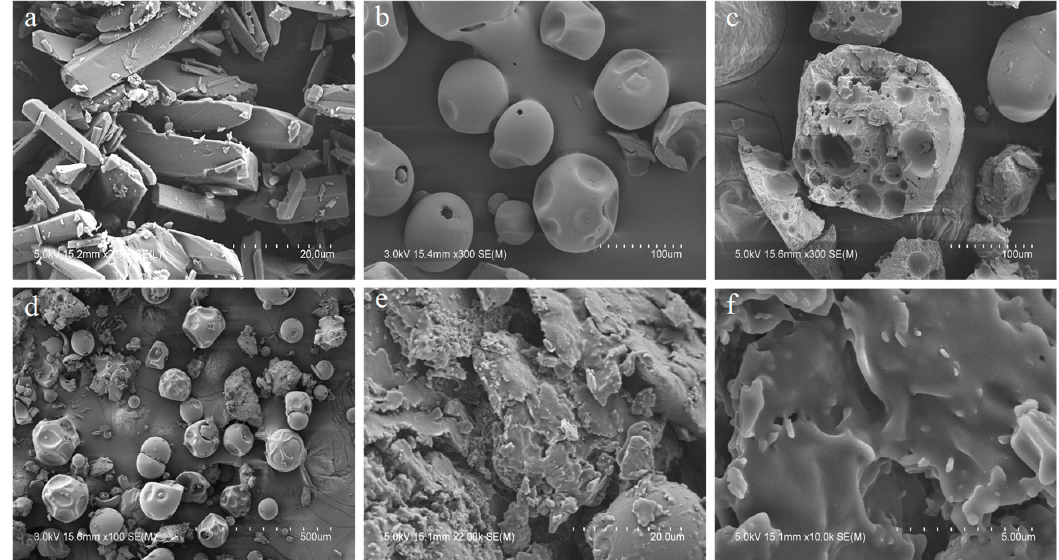
Figure 10. SEM images of LW6 ( a ); PVP K30 ( b ); Poloxamer 407 ( c ); PM ( d ); and F8-SD ( e , f ). Scale bar: